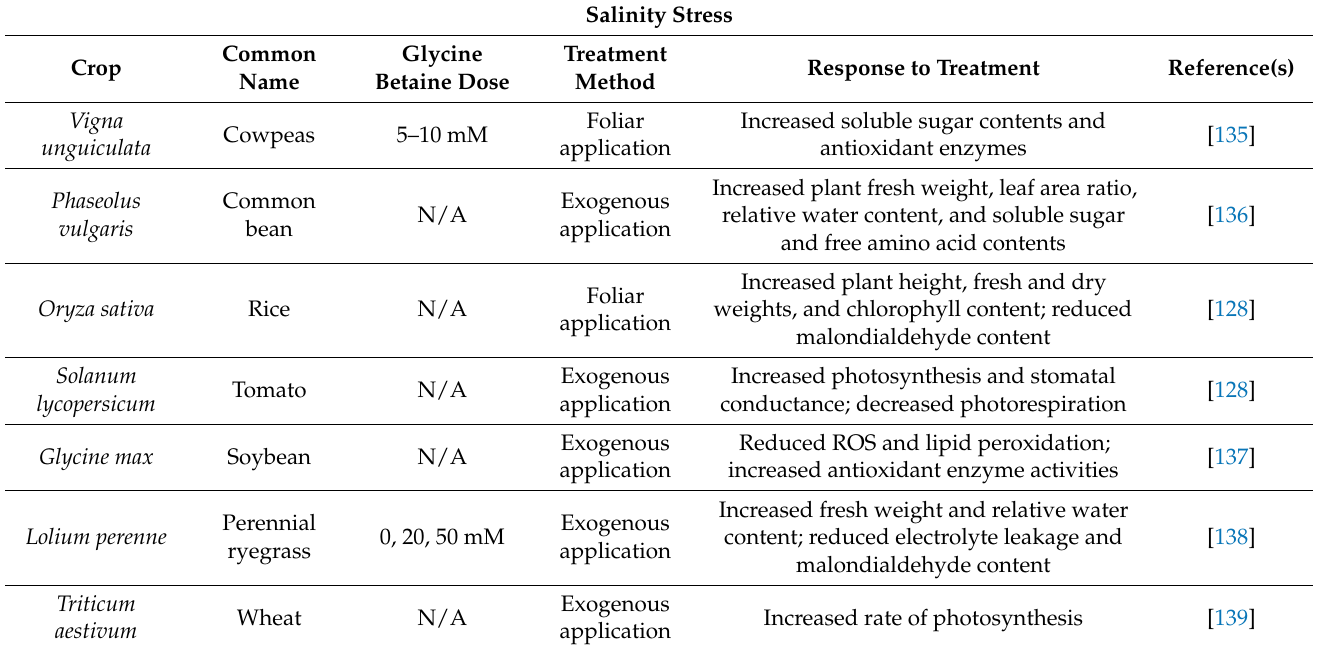
Table 17. Physiological responses of various crops to glycine betaine treatment against salinity stress. Salinity